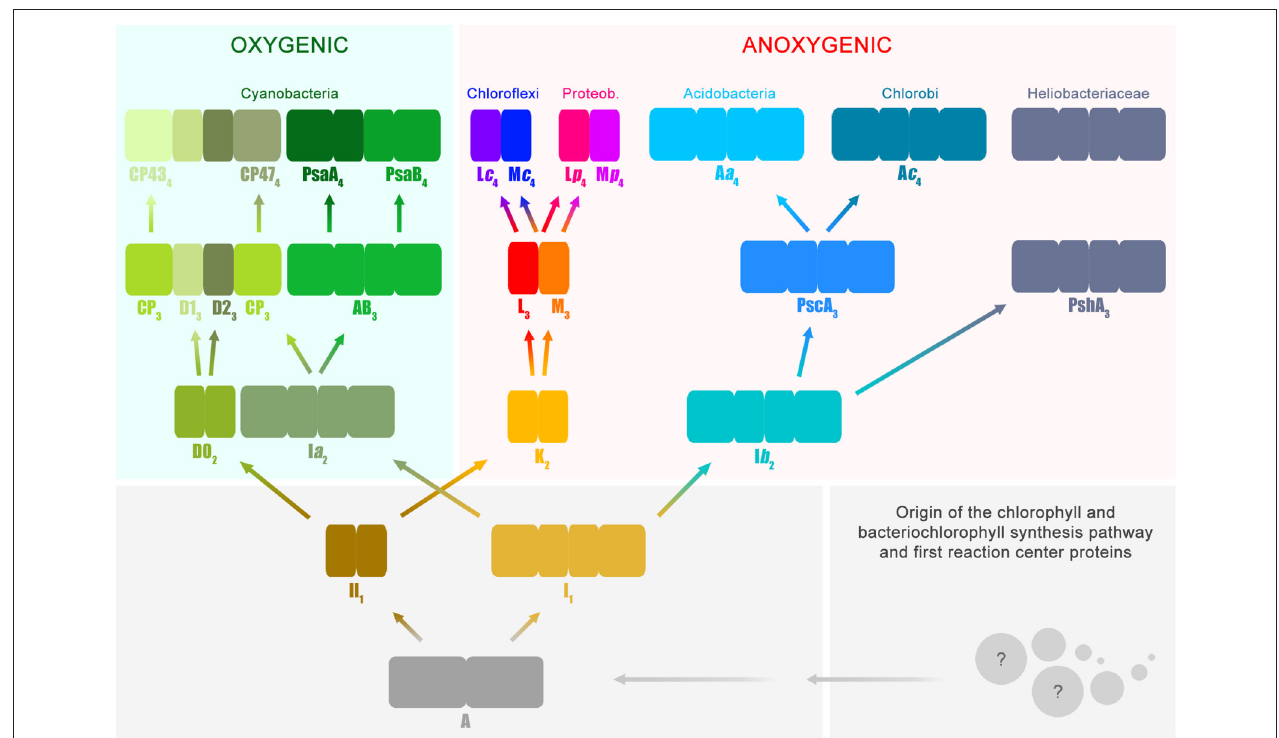
FIGURE 1 | Evolutionary relations of reaction center proteins. This scheme is based on the well-known phylogenetic relationships of reaction center proteins, which I have reviewed in detail before (Cardona, 2015). At the bottom right, the spheres with question marks represent the earliest evolutionary events that led to the evolution of the chlorophyll and bacteriochlorophyll synthesis pathway and the first reaction center proteins. It has been suggested that reaction center proteins might have originated from single-helix pigment-binding proteins (Allen and Vermaas, 2010) or from proteins related to the respiratory Cytochrome b proteins (Xiong and Bauer, 2002 ). Both hypotheses merit further consideration. The ancestral reaction center protein A gave rise to two new classes of proteins ancestral to Type I ( I 1 ) and II ( II 1 ), respectively. It is highly likely that these early stages of reaction center evolution occurred at a time well before the radiation of modern bacterial forms. Therefore, it is difficult to envision the mechanisms by which the ancestral reaction center evolved into two new forms and the evolutionary forces that aided such divergence. The subscript indicates transitional stages away from ancestral protein A . Both I 1 and II 1 separated into two new classes of proteins, one lineage led to the evolution of Photosystem I and II, employed in oxygenic photosynthesis and today only found in the phylum Cyanobacteria and photosynthetic eukaryotes. The other lineage led to the type of reaction center proteins employed by anoxygenic phototrophic bacteria. Type I reaction centers (longer rectangles) are characterized by having 11 transmembrane helices: the first 6 helices are the antenna domain in charge of light harvesting and the last 5 helices are the reaction center domain in charge of photochemistry. In Type II reaction centers (smaller rectangles) the first 6 helices are missing, and only the reaction center domain is found, the last 5 helices. Photosystem II is unique because it is associated with antenna proteins, the CP43 and CP47 subunits, which originated from a Type I reaction center. The nature of the ancestral reaction center protein A is uncertain, was it more like a Type I or Type II reaction center? Did it have an iron-sulfur cluster or a non-heme iron? Did it have an antenna domain or was this fused later with a reaction center protein to make the first Type I reaction centers? At the moment, from the existing structural